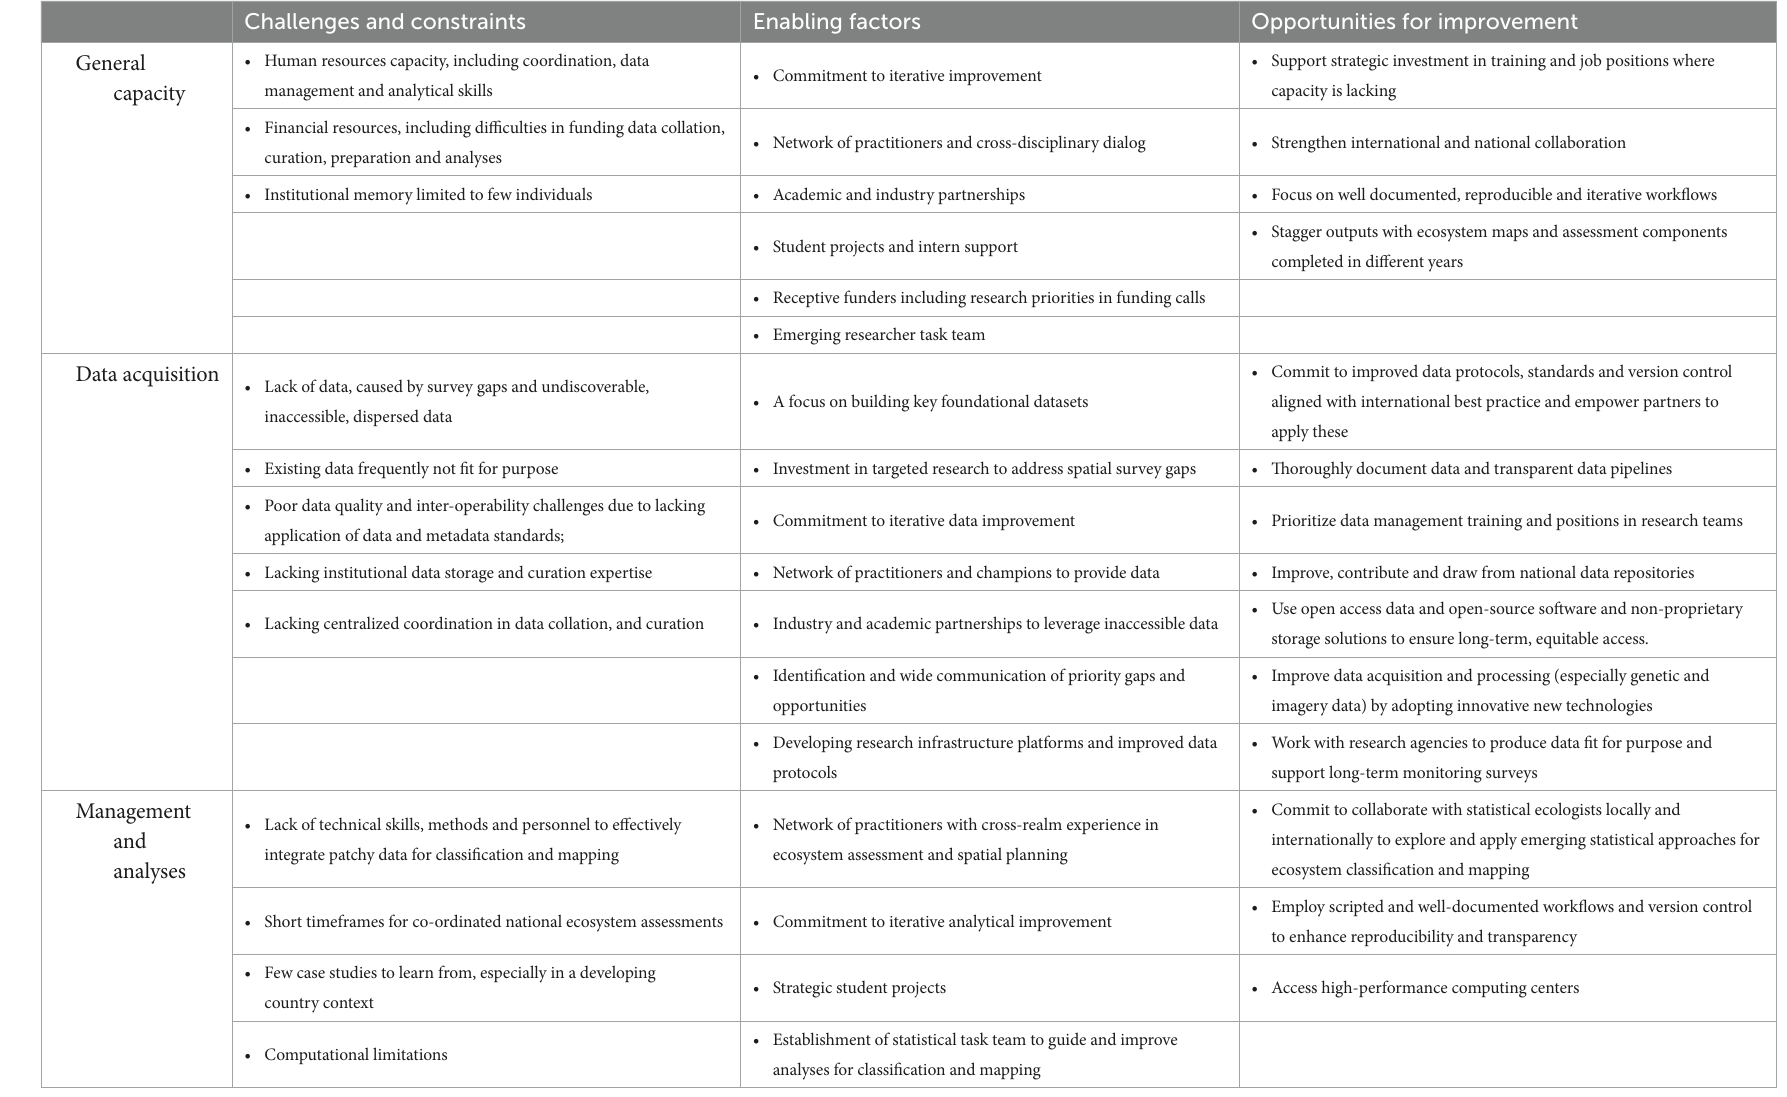
TABLE 2 Challenges, enabling factors, and further opportunities for improvement, as identified by authors during reflections from more than a decade of efforts to improve ecosystem